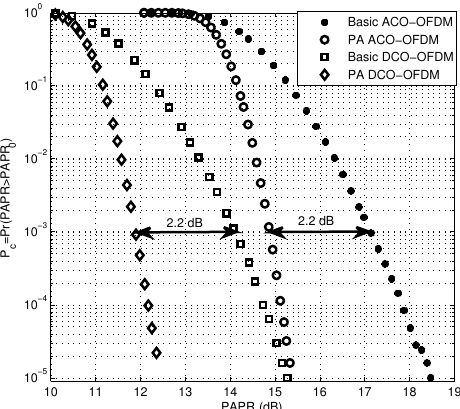
Figure 5. The complementary cumulative istribution function (CCDF) plot illustrating the peak-to-average power ratio (PAPR) reduction capability of PA technique in ACO-OFDM and DCO-OFDM using U = 5, 4-QAM and 127 active subcarriers (Pc is the probability that PAPR exceeds a particular defined value of PAPR 0